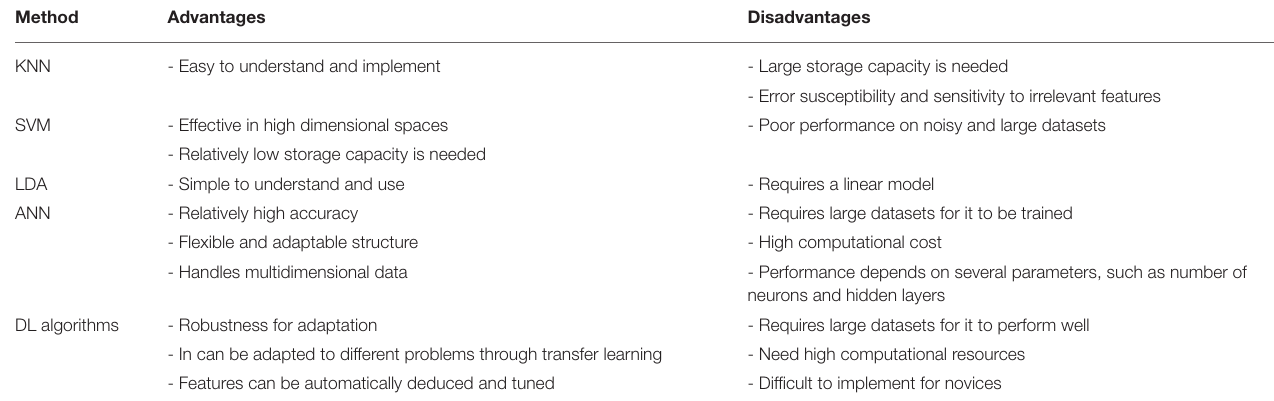
TABLE 8 | Comparison of classification methods.